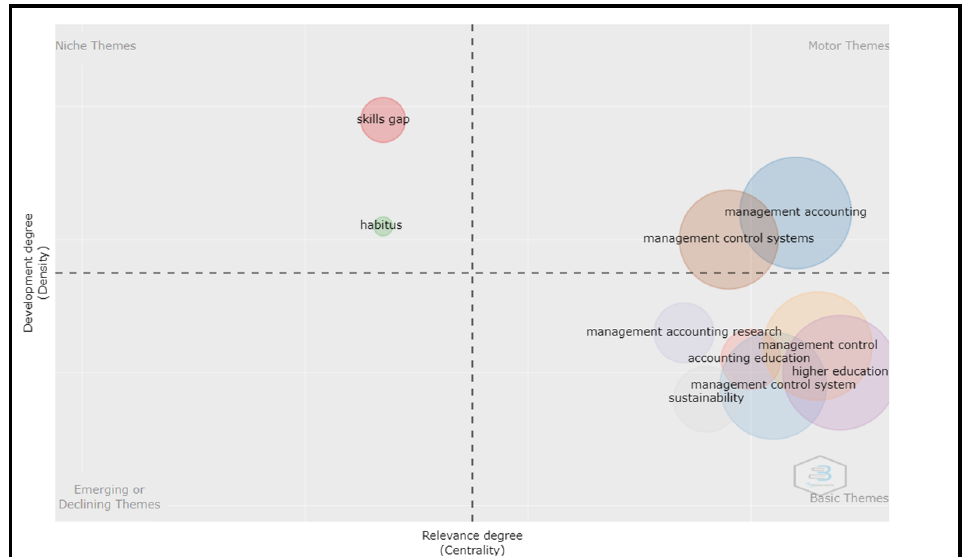
Figure 6. Thematic Figure 6. Thematic evolution.